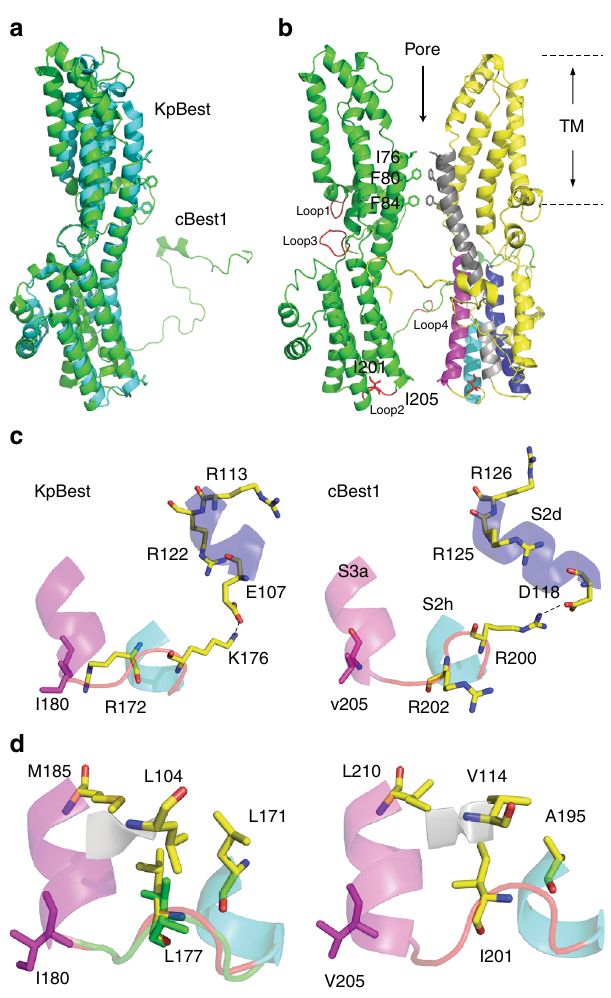
Fig. 7 Structural analysis of bestrophin channels. a Structure alignment of KpBest (blue) and cBest1 (green) as shown by superposition of their protomers. b Ribbon diagram of two oppositely facing (144°) protomers of an hBest1 pentamer is shown with the extracellular side on the top. The side chains of I201 are in red. Loops 1 – 4 on the left protomer are in red. Helices surrounding the ATP-binding loop on the right protomer are labeled in the same colors as those in (c, d), Fig. 3A and Figure S5 for comparison. c Visualization of the ATP-binding loop (red), and critical residues potentially involved in ATP binding. Left, KpBest; right, cBest1. d Visualization of the ATP-binding loop (red for WT and green for the L177T mutant) and the surrounding hydrophobic residues. Left, KpBest; right,